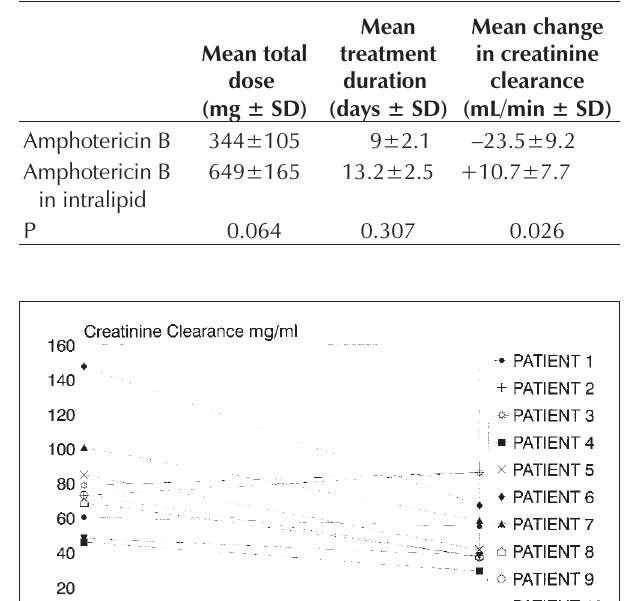
Comparison of aqueous amphotericin B and amphotericin B in intralipid for dosage and renal function